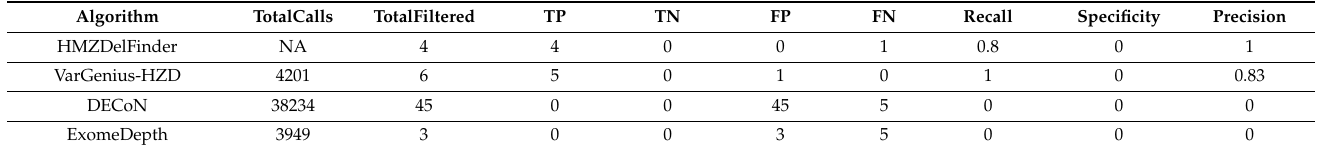
Table 2. Precision/recall/specificity obtained by the tools used with the synthetic HD test.